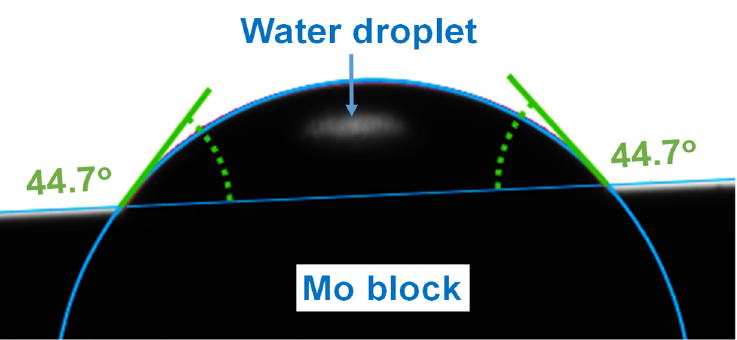
Figure 10. The contact angle measured by the Krüss goniometer using water on a polished Mo